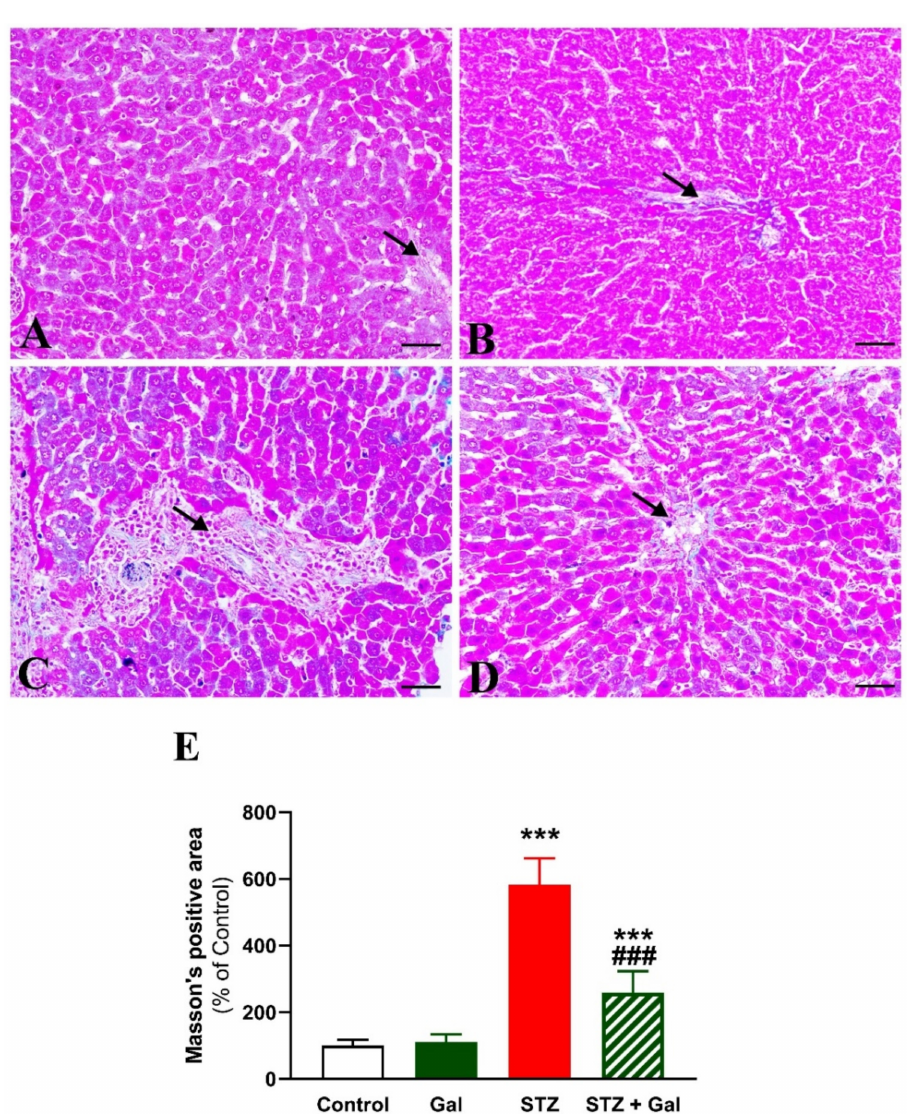
Figure 5. Photomicrographs of MT-stained sections in the liver of ( A ) control and ( B ) galangin- supplemented rats showing few collagen fibers around the portal area (arrow), ( C ) diabetic rats showing periportal fibrosis (arrow), and ( D ) diabetic rats treated with galangin showing marked decrease in collagen deposition. (Scale bar = 50 µ m). ( E ) Image analysis showing significant increase in collagen deposition in diabetic rats and the ameliorative effect of galangin. Data are mean ± SEM, n = 6. *** p < 0.001 versus control and ### p < 0.001 versus